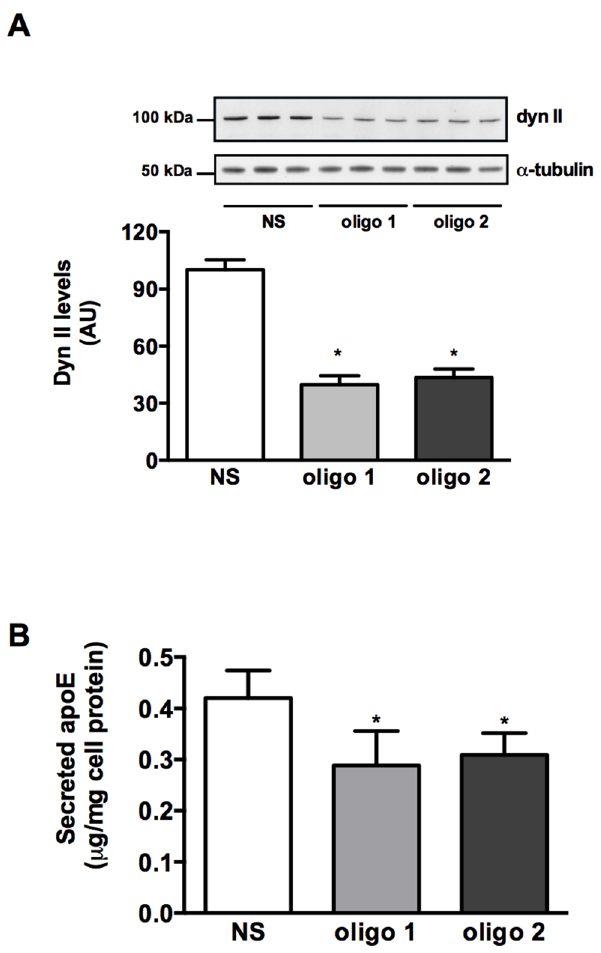
Figure 2. Silencing of dynamin II decreases apoE secretion. HMDM were incubated with 150 nM non-silencing or dyn II siRNA oligo’s for 48 h, followed by a further incubation for 72 h in RPMI containing 10% LPDS and 50 m g/mL AcLDL. After loading apoE secretion was determined over a 2 h period in 0.1% BSA in RPMI. Cellular dynamin II levels (A) and secreted apoE (B) were determined by Western blotting and ELISA, respectively. Data are mean 6 SD from triplicate cultures representative of at least 2 individual donors. * P , 0.05 v Ctrl.